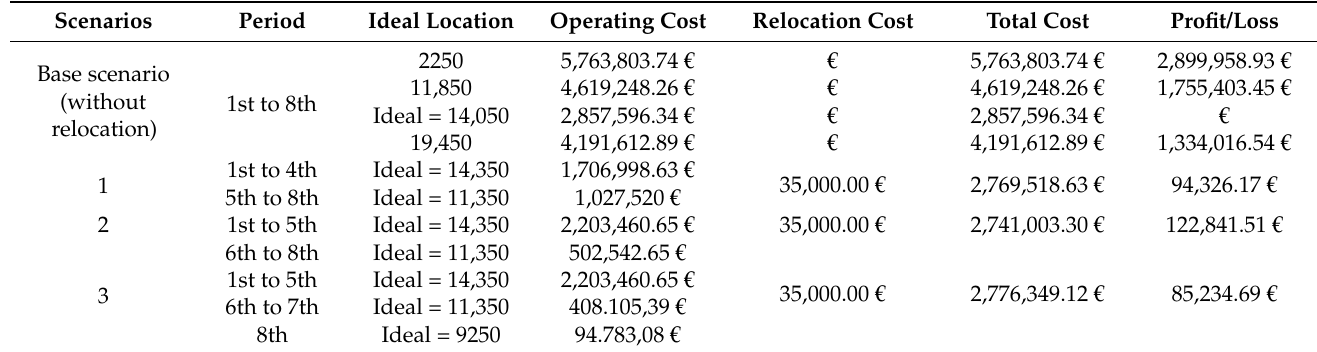
Table 8. Operating costs results of the third project.